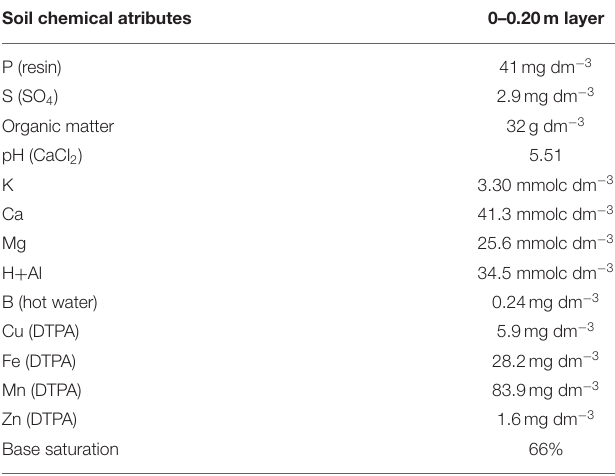
TABLE 1 | Soil chemical attributes in 0–0.20m layer before the beginning of the wheat field trial. Soil chemical